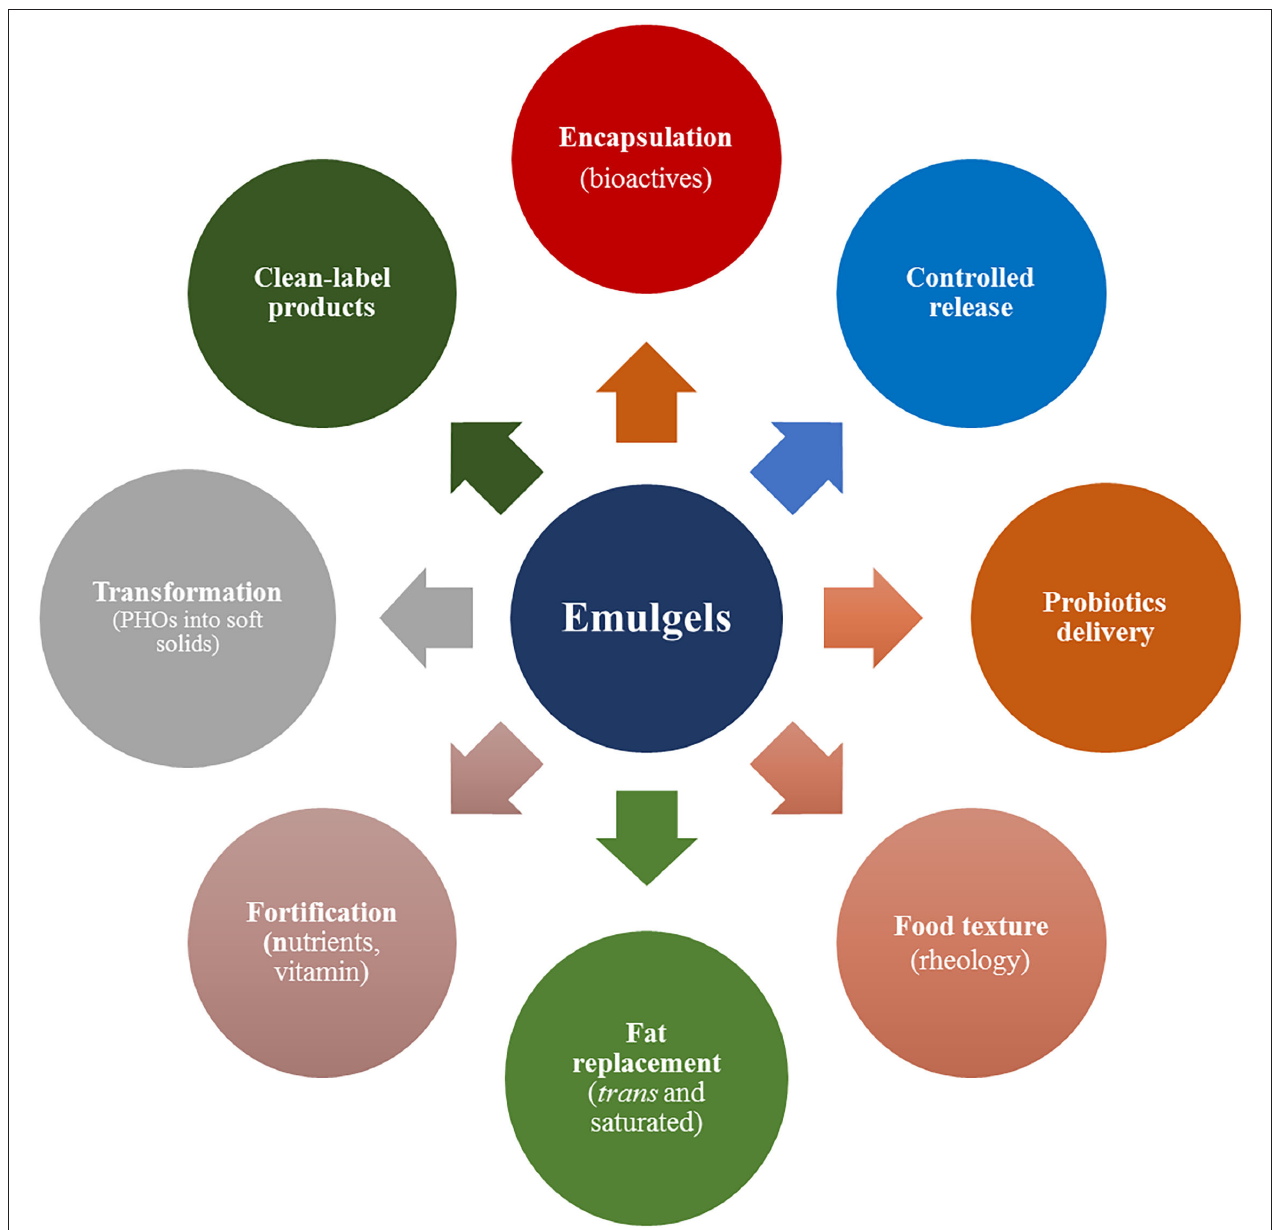
FIGURE 5 | Emerging industrial food applications of emulsion gels